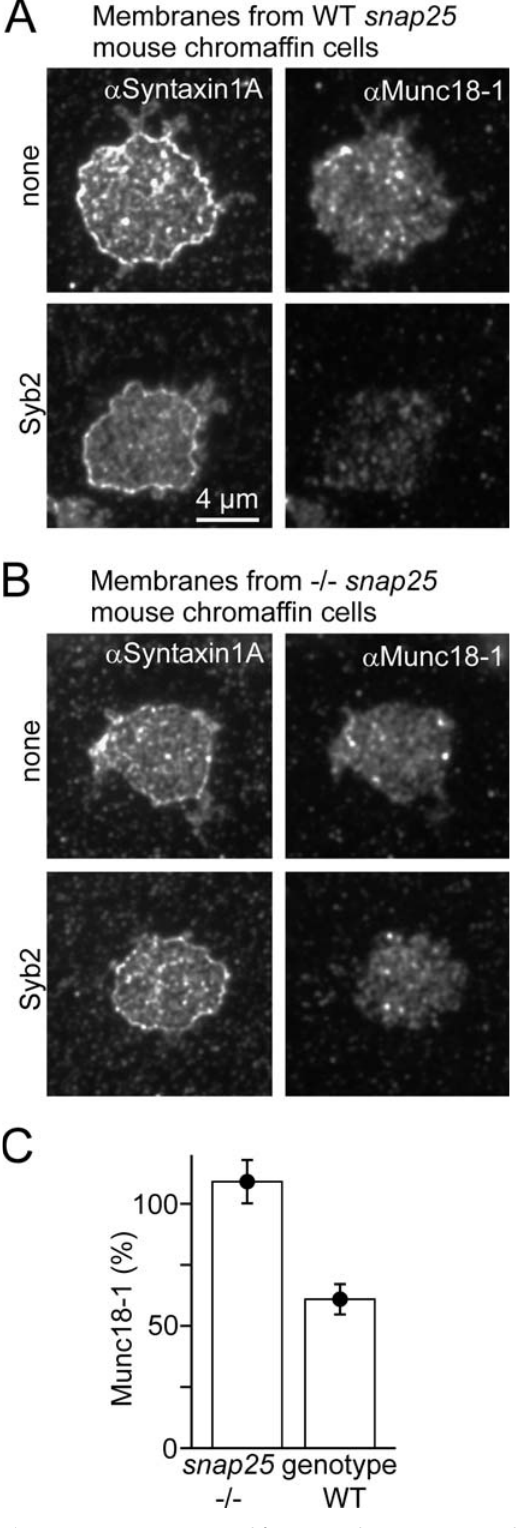
Figure 5. SNAP-25 Is Essential for Synaptobrevin 2–Triggered Munc18–1 Release Membrane sheets were prepared from mouse embryonal chromaffin cells (E16–E18), isolated from wild-type or snap25 knockout animals. Membrane sheets were incubated for 10 min in the absence or presence of 10 l M synaptobrevin 2, fixed, and immunostained for Munc18–1. Syntaxin was also visualized by immunostaining in order to make